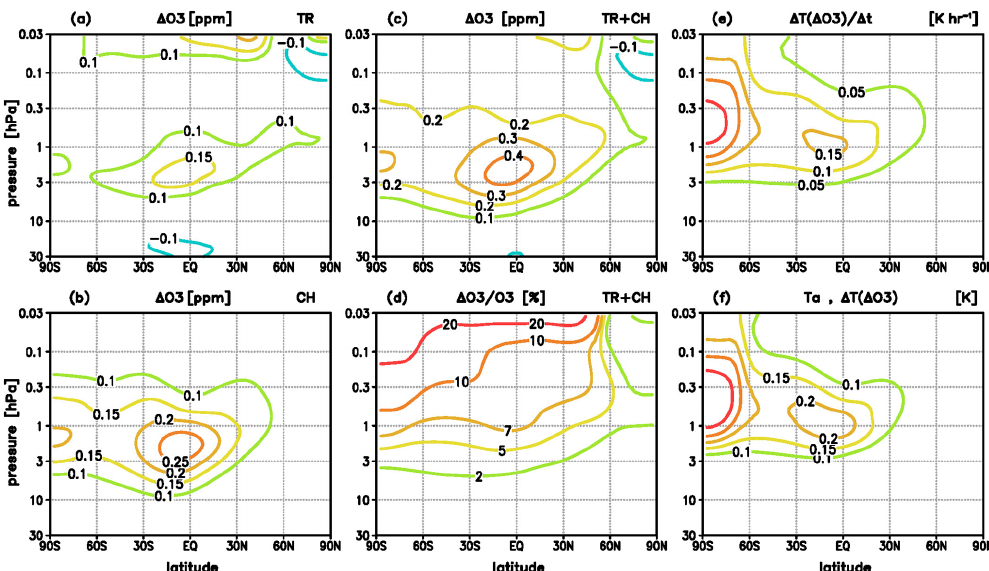
Figure 2. Changes due to ozone–temperature coupling at a specific level induced by an initial GW perturbation with horizontal and vertical wavelengths L k = 500km and L m = 5km, and with exponential increase in amplitude with height (initial temperature amplitude T a ( zs ) = 1K at zs ≈ 35km; p = 6 . 28hPa). (a) Change in ozone due to vertical transport, (b) change in ozone due to photochemistry, (c) total change in ozone, (d) relative change in ozone, (e) change in the heating rate, and (f) change in the temperature perturbation.